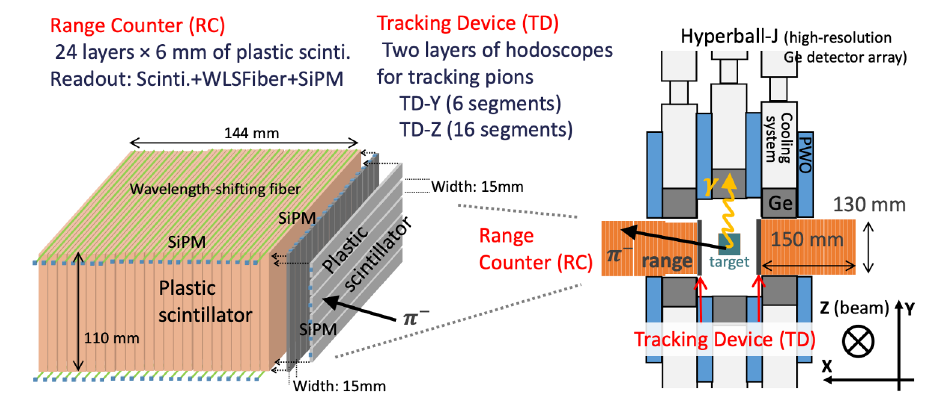
Figure 3. (Left) The range counter system, which is composed of a range counter and a tracking device. (Right) The system is installed inside the